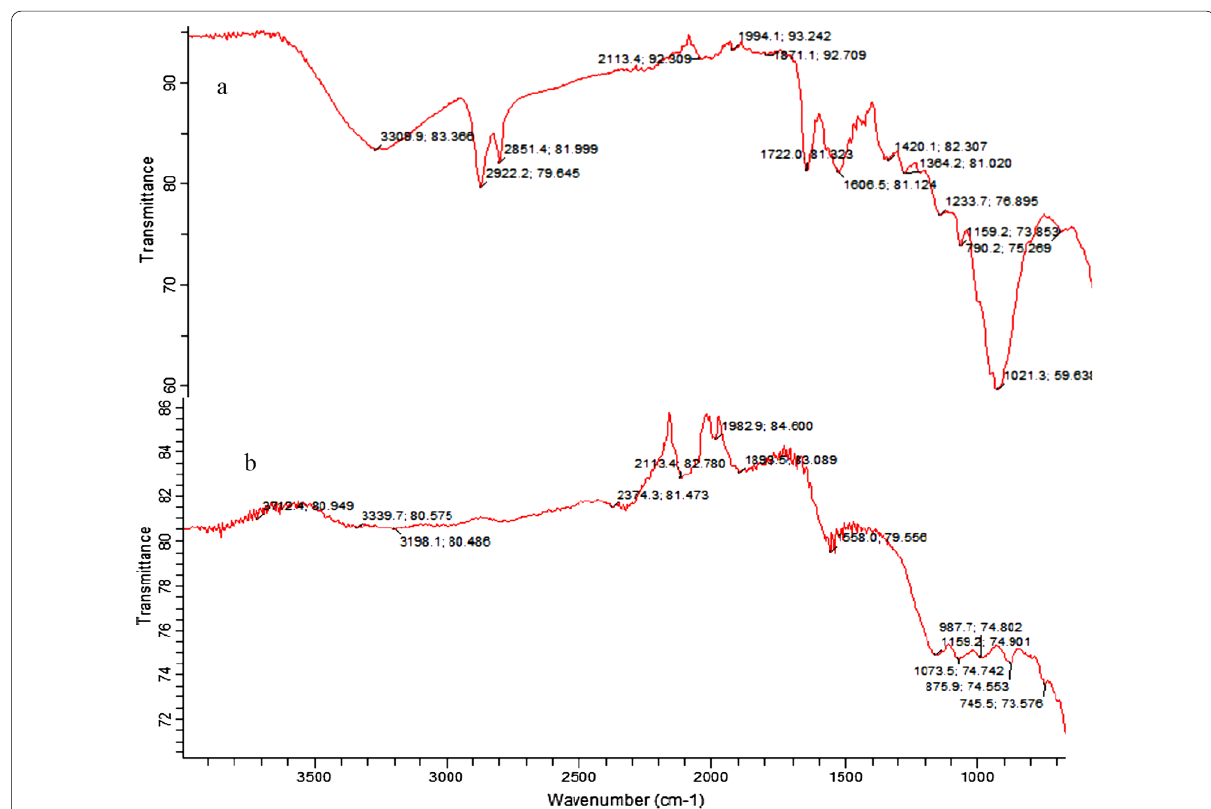
Fig. 3 FTIR Spectra of a raw Dialium guineense pods and b Dialium guineense pods active carbon